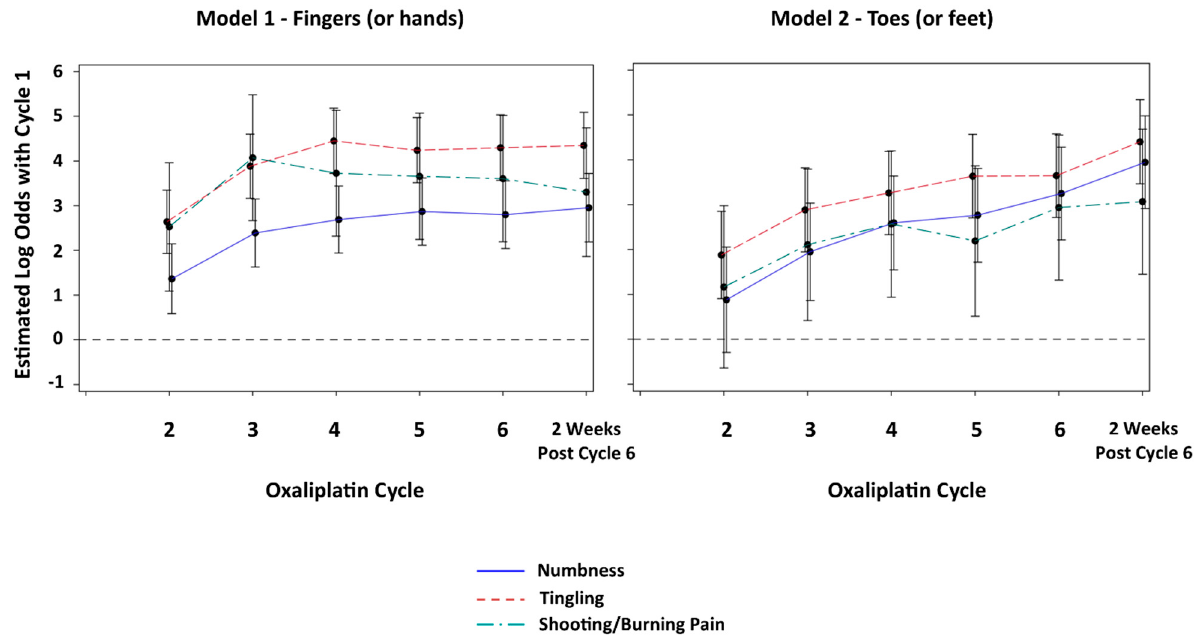
Figure 1. Estimated log odds of a more severe response at cycles 2, 3, 4, 5, 6 and at 2 weeks post- cycle 6 compared with cycle 1 (baseline) for numbness, tingling and shooting/burning pain in the fingers (or hands) ( LEFT ) and in the toes (or feet) ( RIGHT ).